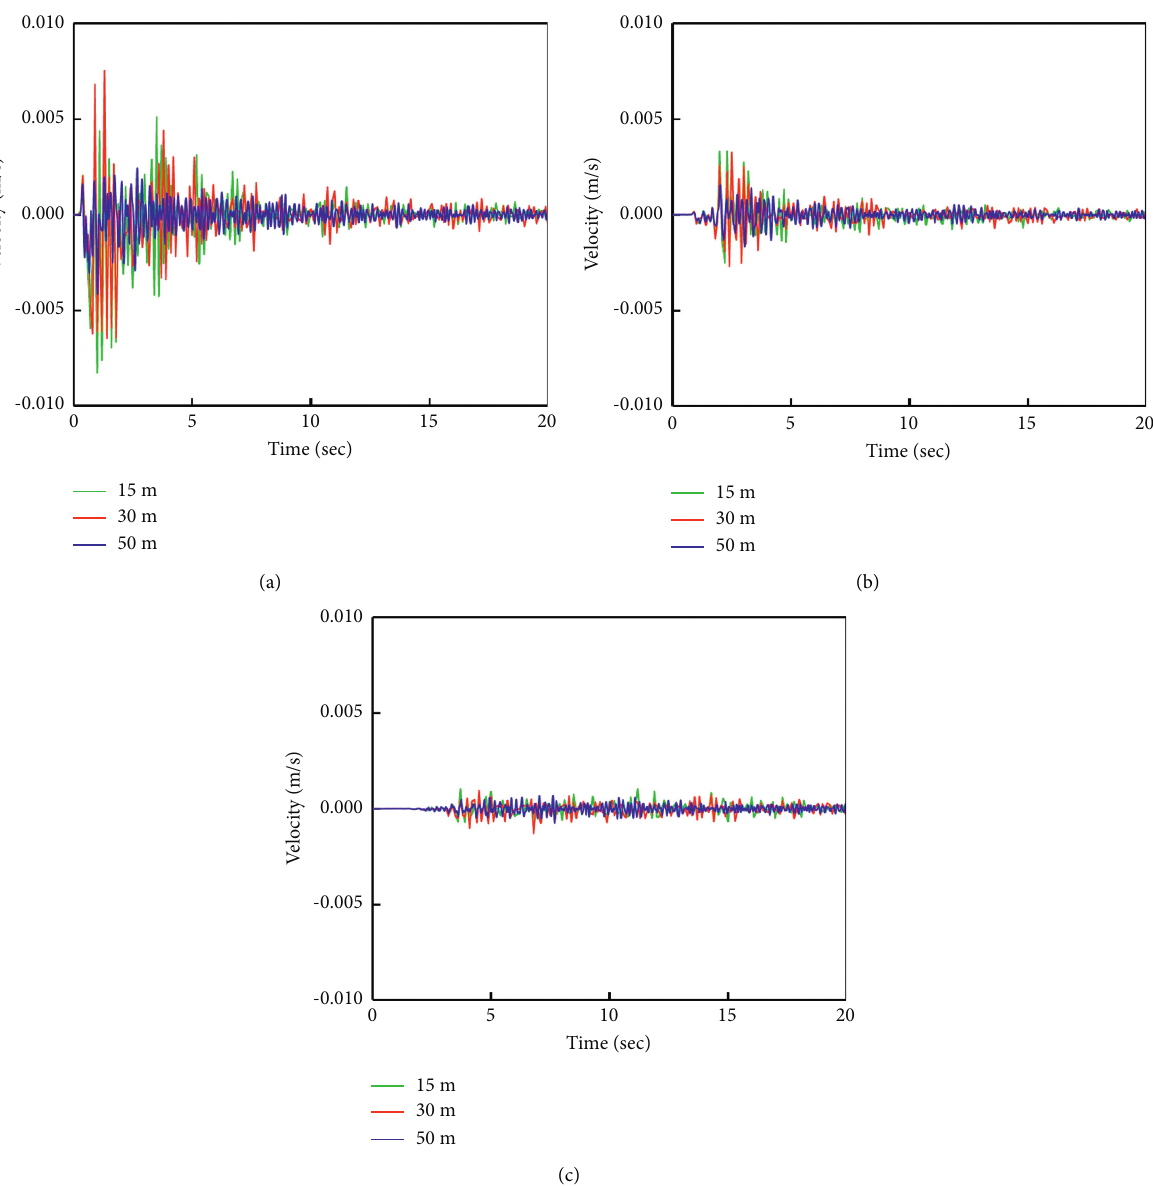
Figure 11: Comparison of the time-history curves of the peak vertical vibration velocities at different measuring points for the two-hammer condition with different time intervals (for the vertical arrangement): (a) 50 m measuring point, (b) 100 m measuring point, and (c) 200m measuring